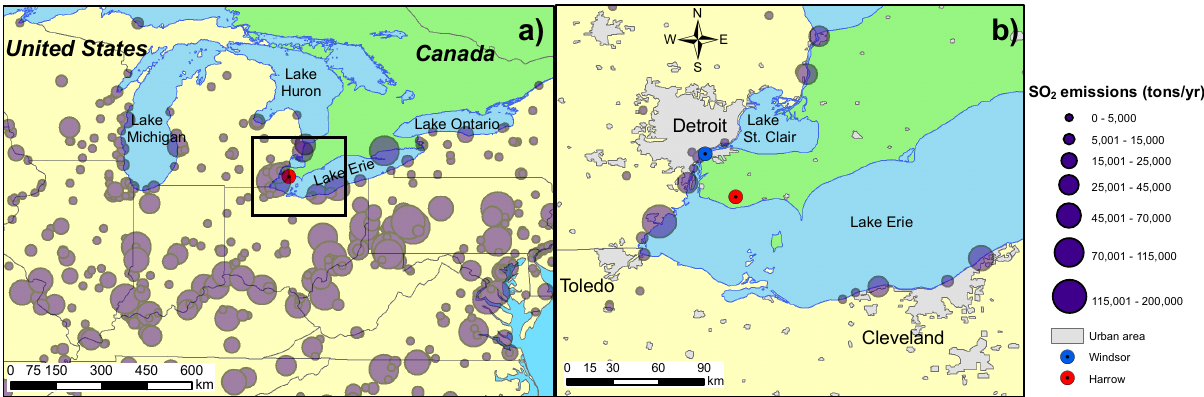
Fig. 1. Location of the receptor site, Harrow, Ontario within North America (42 ◦ 1 0 58.95 00 N, 82 ◦ 53 0 35.61 00 W). The distribution of coal-fired power plants is illustrated by SO 2 emissions in (a) . Shown in (b) is the location of the receptor site within the BAQS-Met region relative to several large cities, including Windsor, Ontario, where the CRUISER mobile laboratory was stationed (42 ◦ 16 0 59.00 00 N, 83 ◦ 5 0 5.00 00 W).